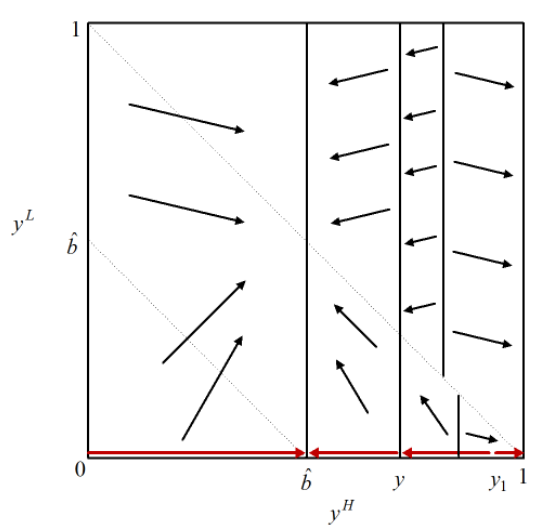
Figure 3. The Monopoly Equilibrium